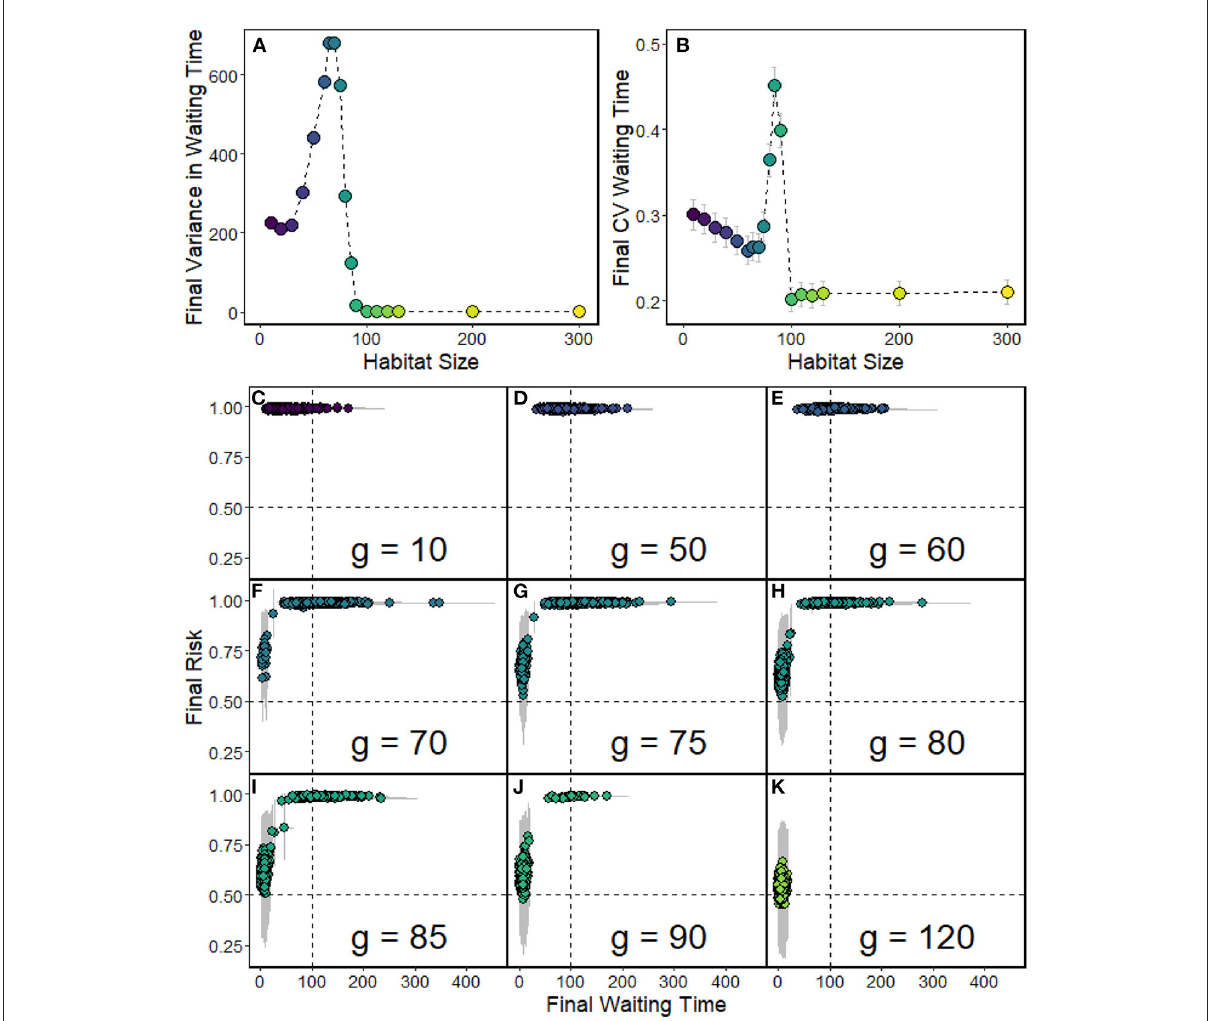
FIGURE6 Variation in WT. Data from the same simulation shown in Figure 3, therefore using default parameters as shown in Table 1, and various habitat sizes g , number of replicates = 1,000. (A) Average variance in WT within replicates. (B) Average coefficient of variation (CV) in WT within replicates. (C–K) Points show the average WT in the final (last day) population plotted against average individual risk r , which is the probability for selfed offspring of an individual dying of ID. Each point represents one replicate (note that many points overlap). The gray bars represent within-replicate standard deviations for both x and y-range. Each panel shows a different habitat size g